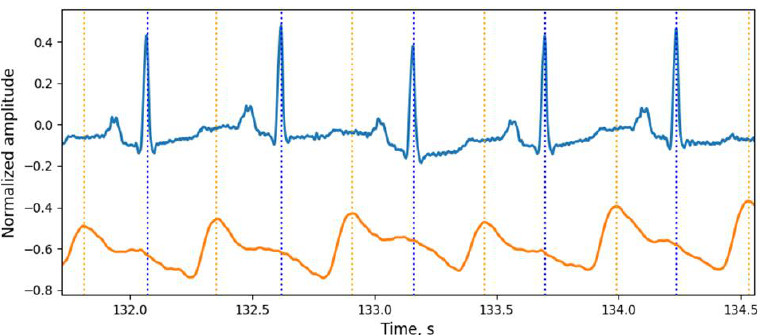
Figure 11. Examples of ECG and PW signals, obtained from the certified Biopac MP36 data logger (medical-grade quality of signals).